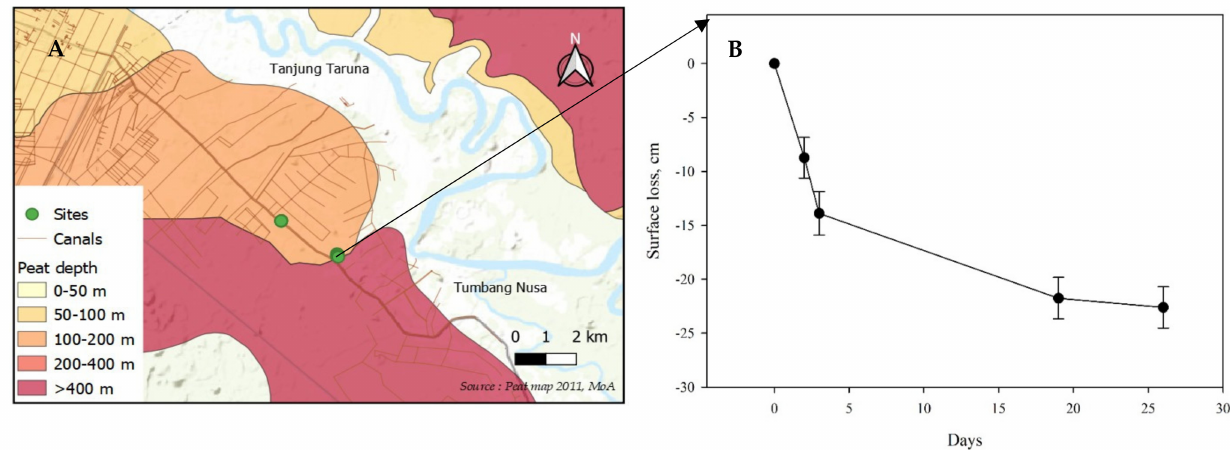
Figure 4. ( A ) Map of the peat depth at the study sites, ( B ) loss of the peat surface during peat fires in September 2019 at Site 2 as measured from two transects, Central Kalimantan. Error bars are the standard error (s.e.) of the mean. As can be seen in Figure 2D, it was not possible to separate the loss of peat from the overall surface